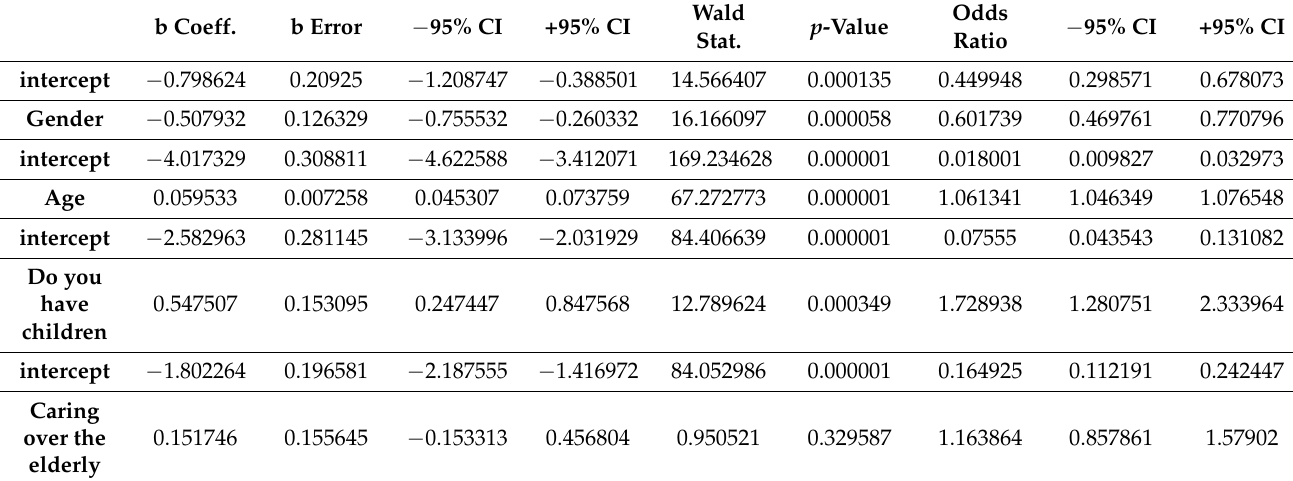
Table 7. Logistic regression model for total fear symptoms and demographics.